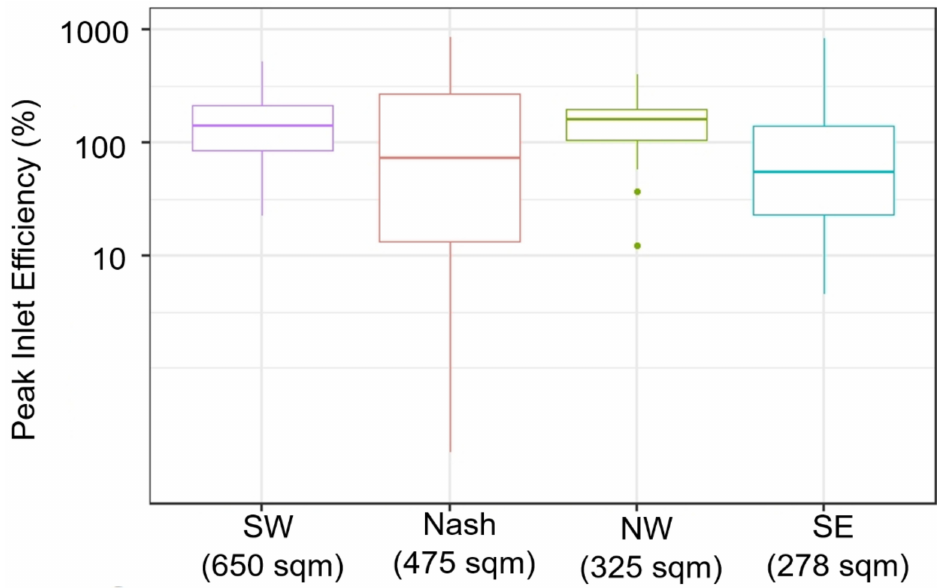
Figure 10. Effect of tributary drainage area on peak inlet